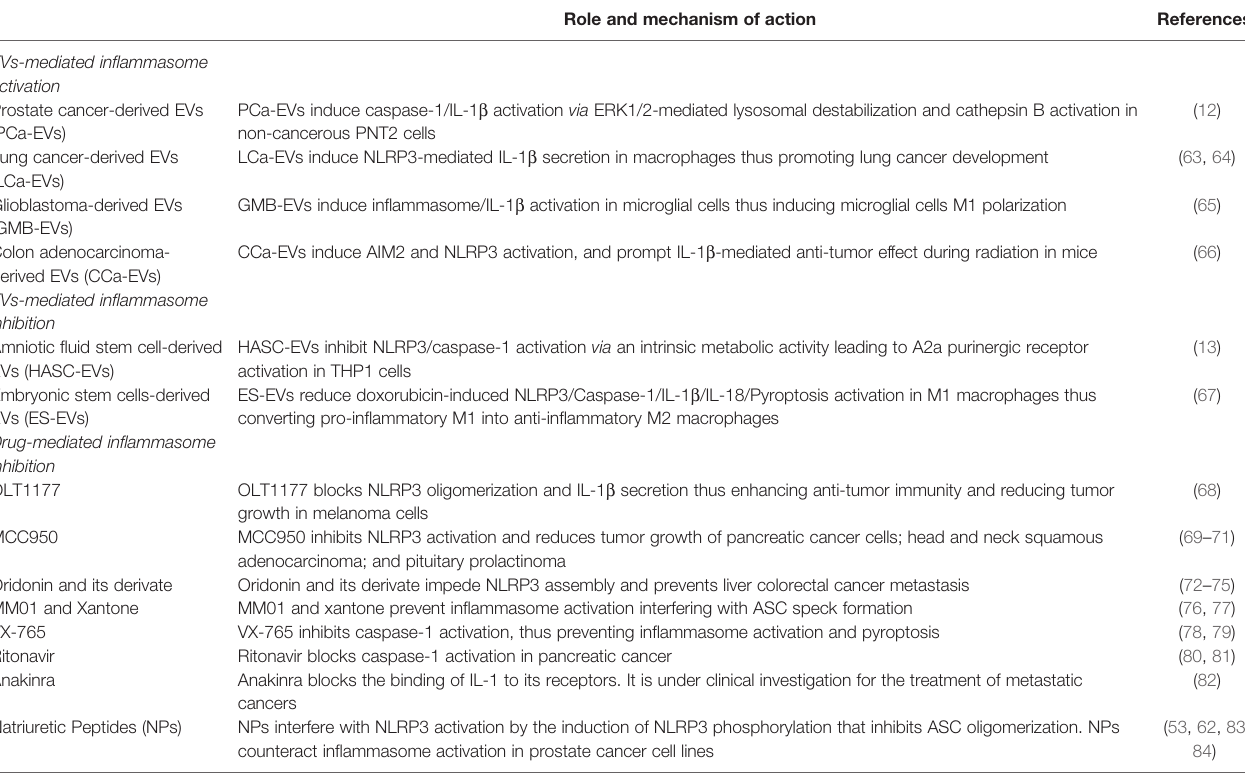
TABLE 1 | Roles of EVs and drugs in in fl ammasome